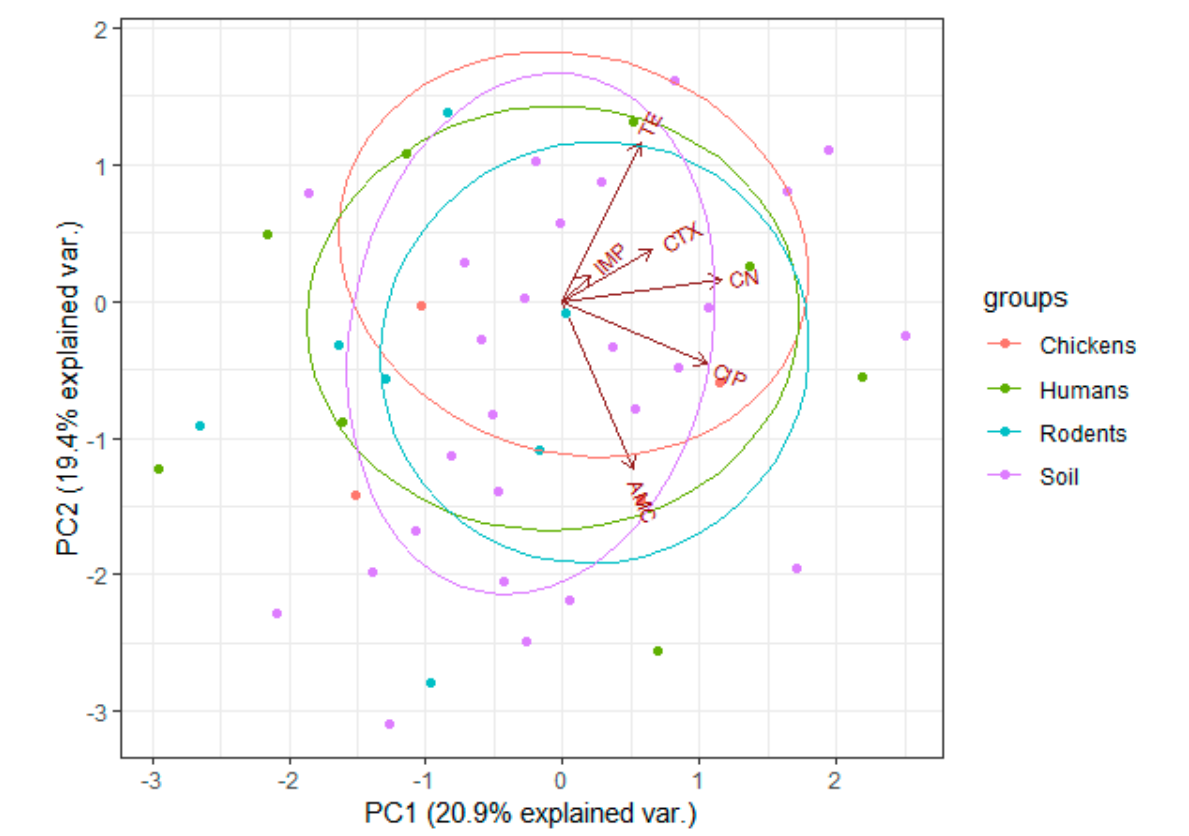
Figure 3. Principal component analysis (PCA) biplots of the antibiotic resistance profiles of E. coli isolated from chickens, humans, rodents and soil samples. For principal component 1 (PC1), the X -axis expresses susceptibility of the isolates to the drugs, while for principal component 2 (PC2), the Y -axis expresses resistance of the isolates. Arrows indicate the antibiotics that were used during resistance screening. The dots represent the E. coli isolates that were resistant to the tested antibiotics with respect to their sample sources. The ellipses indicate a 95% confidence interval of the respective isolates from the same sample source. Table 4. Resistance patterns of 180 MDR E. coli isolates from chicken